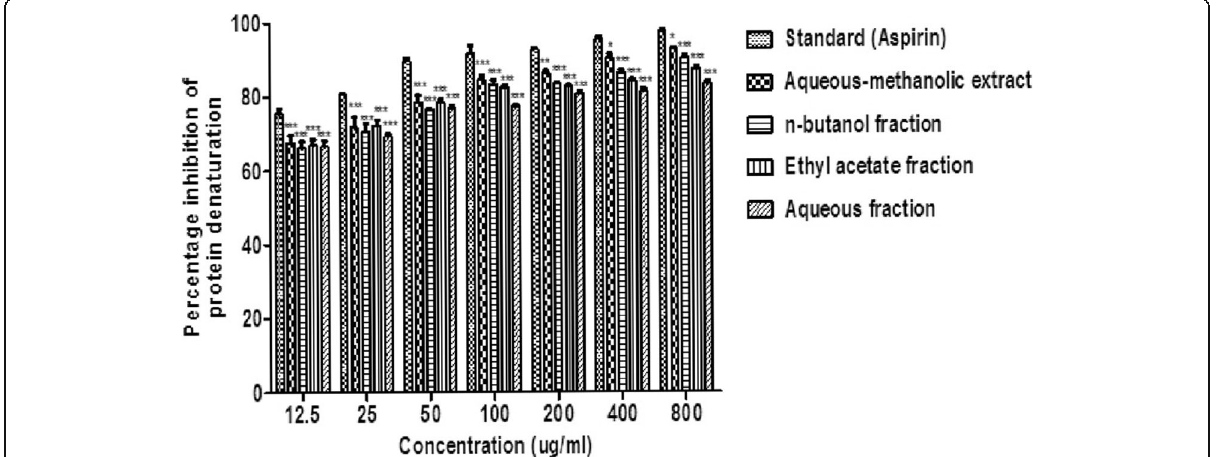
Fig. 1 Effect of B.orthobotrys aqueous-methanolic extract and fractions against protein denaturation using bovine serum albumin. All the values are expressed as mean ± SEM ( n = 3), using two way ANOVA followed by Bonferroni posttest. *** = p < 0.001, ** = p < 0.01, * = p < 0.05 vs aspirin